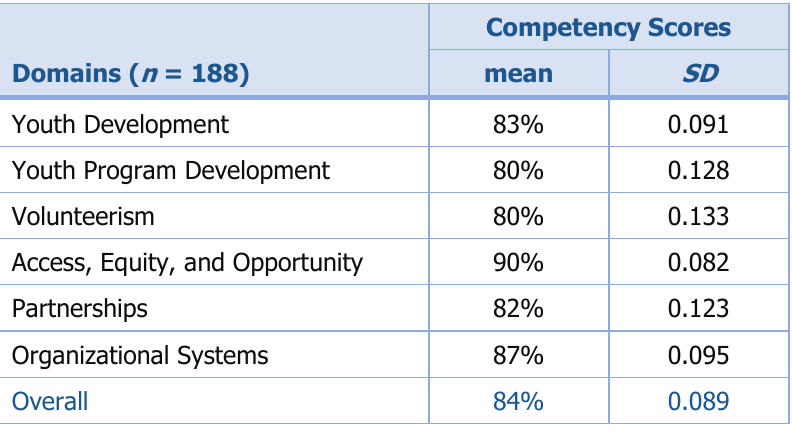
Competency Scores mean